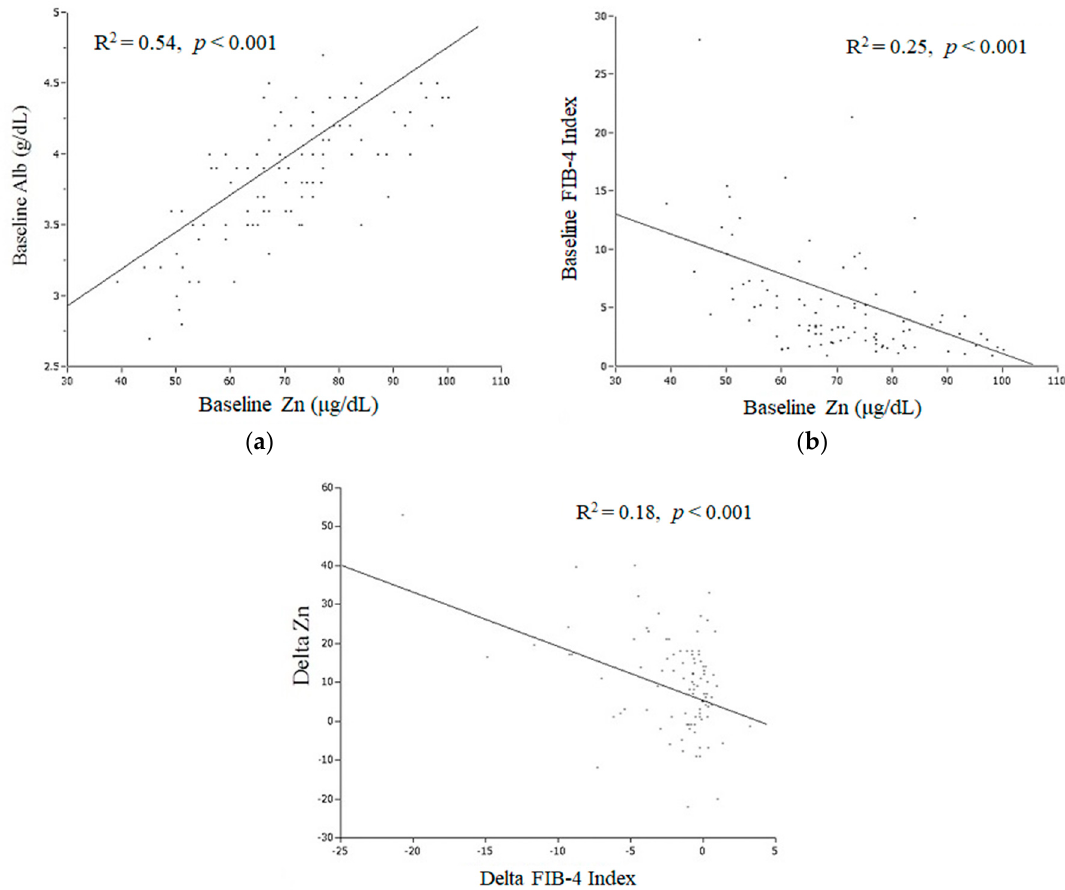
Figure 2. Relationship between Baseline Zn and Other Parameters. ( a ) Positive correlation ( R 2 = 0.54, p < 0.001, linear regression analysis) between baseline Zn and baseline Alb level. ( b ) Negative correlation ( R 2 = 0.25, p < 0.001, linear regression analysis) between baseline Zn and baseline FIB-4 index. ( c ) Change in serum zinc level (delta Zn) and change in FIB-4 index (delta FIB-4 index) from initiation of DAA therapy to two years after achieving SVR showed a negative correlation ( R 2 = 0.18, p < 0.001, linear regression analysis). Alb, albumin; DAA, direct-acting antiviral agent; SVR, sustained